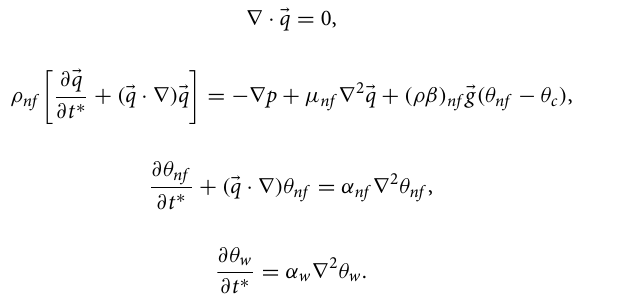
Table 1. Thermo-physical properties of water and nanoparticles. The numerical values are taken from Roy 33 .